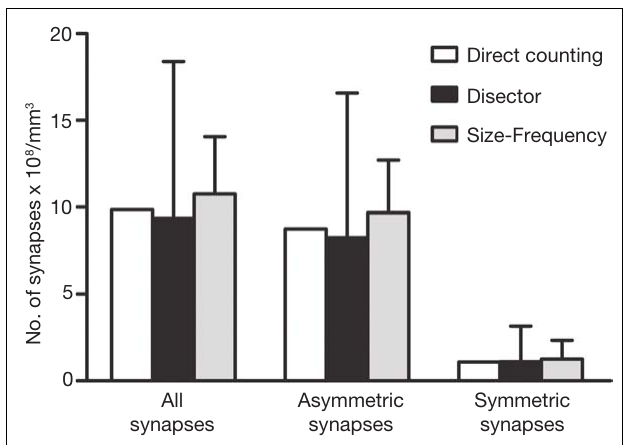
FIGURE 10 | Comparision of the results obtained by directly counting synapses within the counting brick, the disector and the size-frequency methods. The calculation of the number of synapses per unit volume derived by directly counting synaptic junctions within a counting brick of 114 serial sections is represented by white bars. The estimations obtained by means of all possible disectors whose h value was three times the section thickness are shown as black bars (see text and Figure 9 ). Grey bars represent the estimations performed by means of the size-frequency method on all sections. All data were calculated on the same stack of sections. Data obtained from the direct count of the synaptic junctions are unique for a single tissue brick, while data obtained by the disector and size-frequency methods are derived from multiple estimations and they are expressed as the mean ± standard deviation. The results of the three methods are similar but not identical. The differences between the means of the disector and size- frequency methods were not statistically signifi cant. Note that the standard deviations were systematically larger for the disector